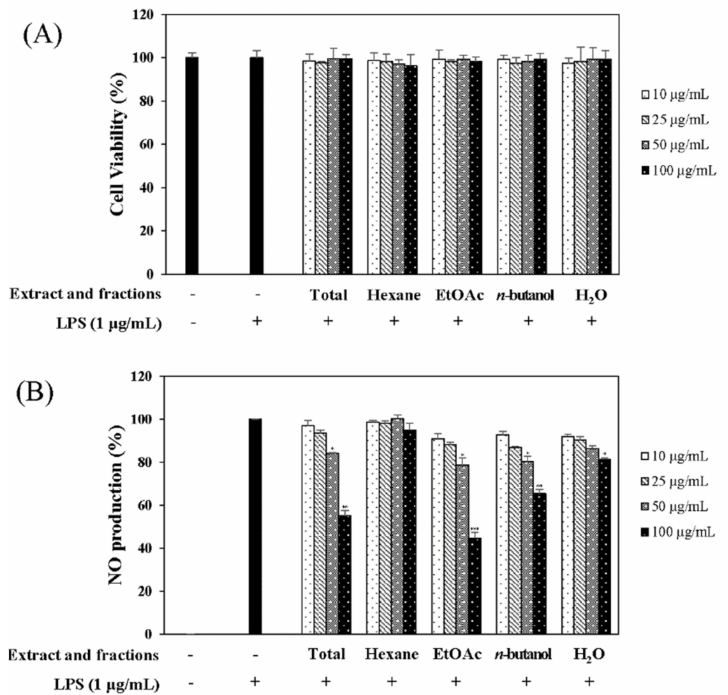
Figure 1. E ff ects of the total extract and extract fractions of Nandina domestica fruits on cell viability ( A ) and nitric oxide production ( B ). RAW 264.7 cells were cultured in the presence of the extracts for 1 h and stimulated with lipopolysaccharide (LPS) (1 µ g / mL) for 16 h. Cell viability and NO production were detected using the MTT (3-[4,5-dimethylthiazol-2-yl]-2,5 diphenyl tetrazolium bromide) assay and the Griess reagent, respectively. Nitrite concentrations from the non-treated and LPS-treated controls were 0.81 ± 0.1 µ M and 17.2 ± 0.2 µ M, respectively. Each determination was made in triplicate. The data are represented as the mean ± SD. * p < 0.05, ** p < 0.01, *** p < 0.001 vs. LPS-treated